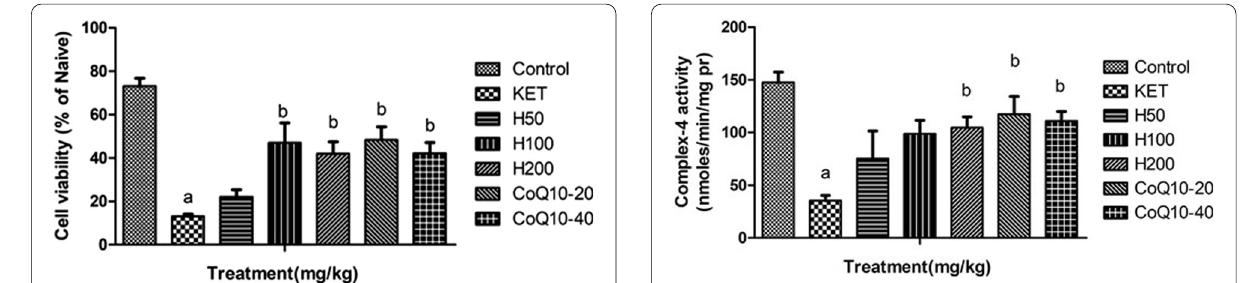
Fig. 15 Effect of hesperidin and Coenzyme Q10 on complex III enzyme (cell viability assay or MTT assay) activity in the prefrontal cortex region of the brain. Data were analyzed by one-way ANOVA followed by Tukey’s post hoc analysis. All values were expressed as Mean SEM. a p < 0.05 as compared to naive, b p < 0.05 as compared to ± ketamine. KET, Ketamine; H, Hesperidin; CoQ10, Coenzyme Q10